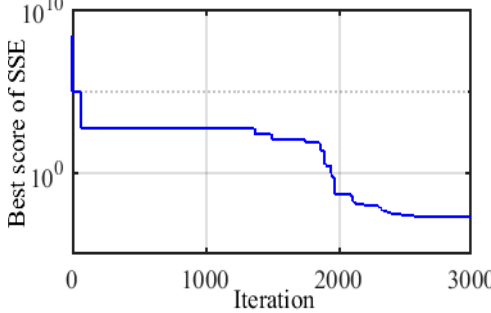
Table 2. Estimated parameters by ASO for SR-12 modular.